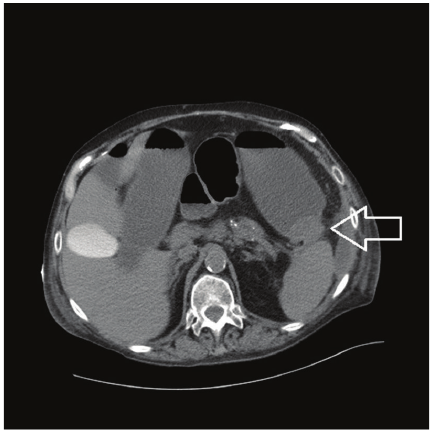
Figure 1: CT abdomen/pelvis done at time of admission to outside hospital showing colonic thickening at the splenic flexure.